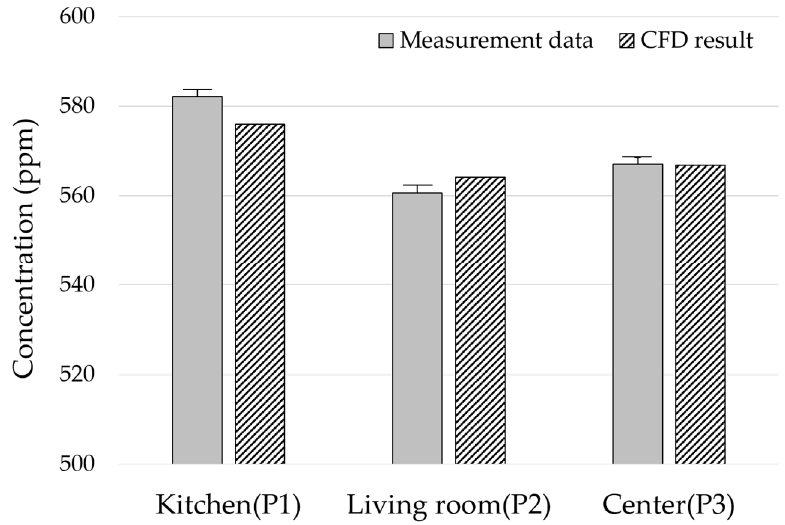
Figure 7. Comparison of CFD and measuring data (concentration of CO 2 ).